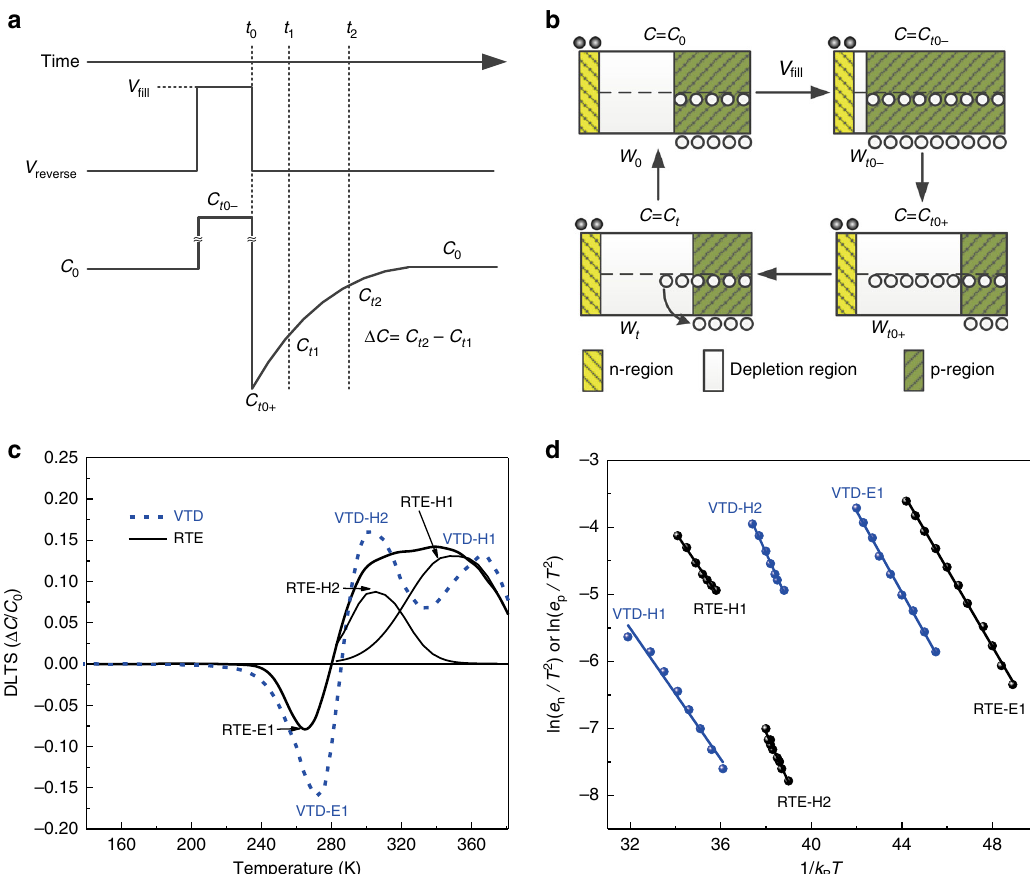
Fig. 5 DLTS analysis of VTD- and RTE-fabricated CdS/Sb 2 Se 3 solar cells. a Schematic demonstration of the mechanism of DLTS measurement. b Variation of depletion width and the process of holes being trapped and emitted during the measurement. c DLTS signals of VTD-fabricated and RTE-fabricated devices at t 1 / t 2 = 1 ms/10 ms. d Arrhenius plots obtained from DLTS signals. C t 0 – and W t 0 – are the junction capacitance and the depletion width at the moment before pulse voltage ended, respectively. C t 0 + and W t 0 + are the junction capacitance and the depletion width at the moment after pulse voltage ended,